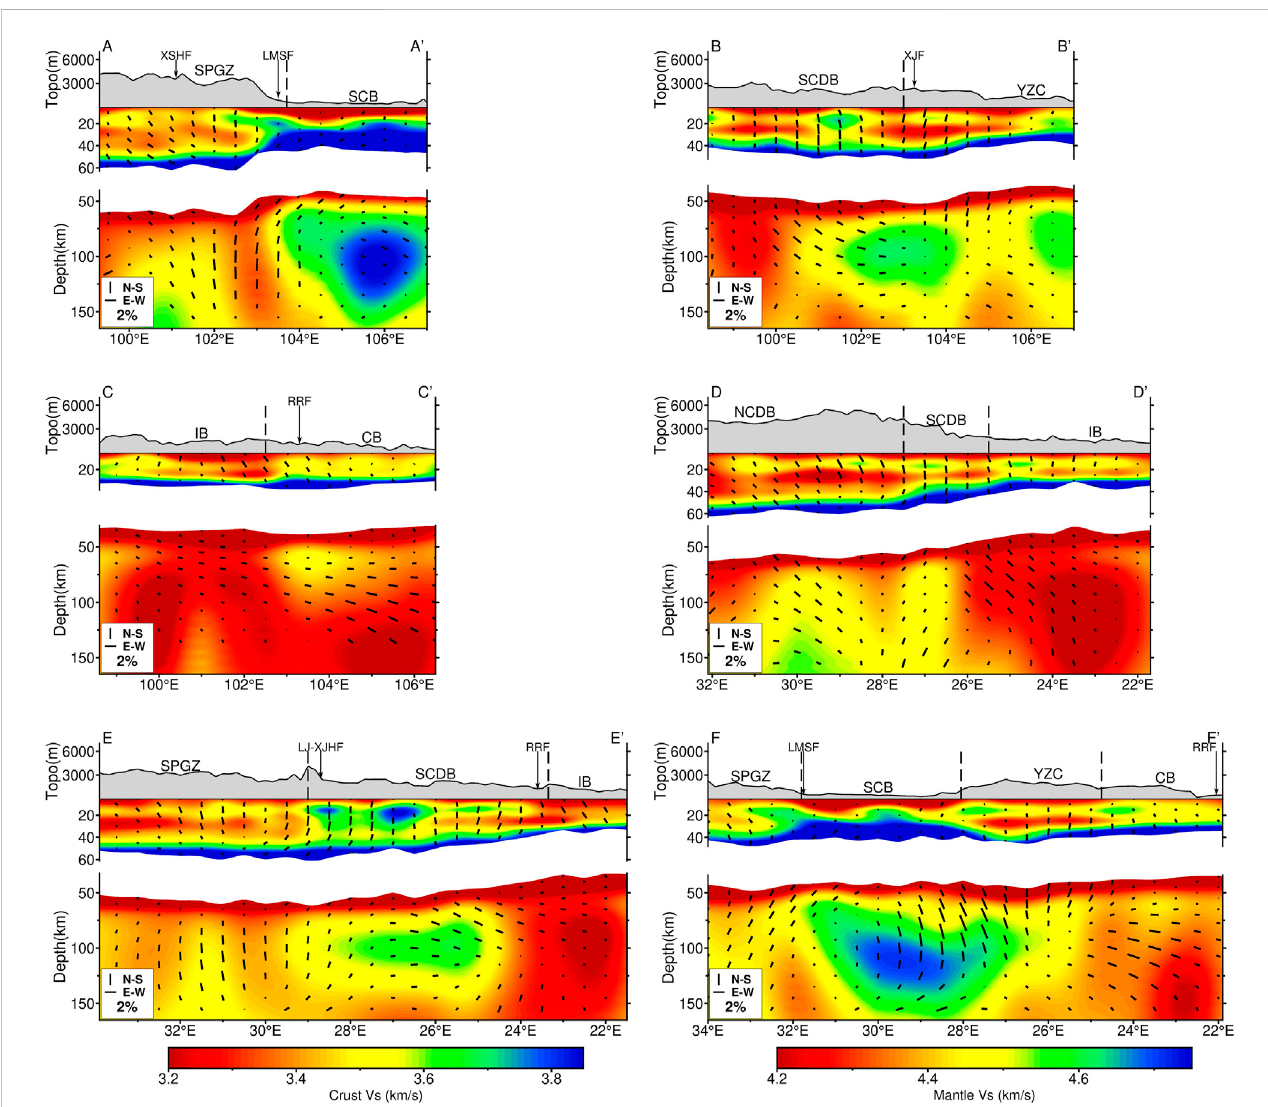
FIGURE 6 Vertical pro fi les (AA ’– FF ’ ) ofshear wave velocity and azimuthal anisotropy structure in the study area. The locations of the pro fi les are marked bytheblack lines in Figure 5B. In each pro fi le, the top part shows the topography along this pro fi le, and the middle and bottom parts show the shear wave velocity and azimuthal anisotropy structure of the crust and mantle, respectively. We separated the crust and mantle according to the Moho depth from He et al. (2014). Dashedlinesandblackarrowsrepresenttheblockboundaryandfaults.TheverticalandhorizontalbarsinthebottomleftcornerrepresenttheN ‒ SandE ‒ W fast directions of the azimuthal anisotropy,